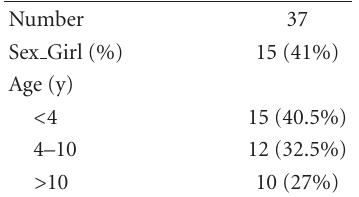
Table 1: Demography of 37 corticosteroid resistant nephritic